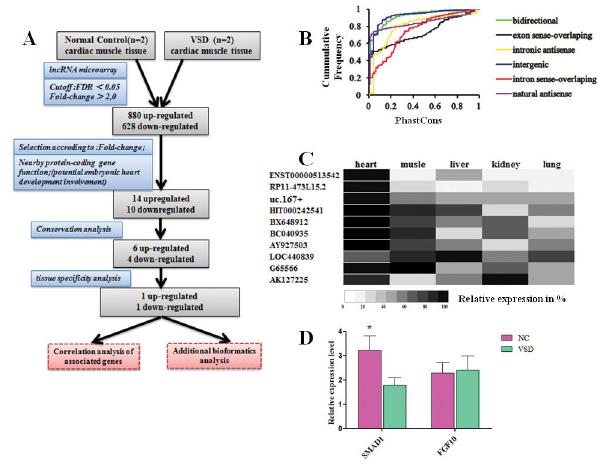
Figure 4. Validation of lncRNA candidates in VSD-affected cardiac tissue. ( A ) The overview of the pipeline for validation of lncRNA candidates in VSD. ( B ) Analysis of the conservation of all classes of dysregulated lncRNAs compared to conservative coding genes revealed an absence of high levels of conservation across species among the majority of lncRNAs. ( C ) The expression of the 10 selected heart expressed lncRNAs transcripts was validated by quantitative PCR in five human fetal tissues. The majority of the tested lncRNAs transcripts are predominately expressed in heart (percentage range; white, 0% to black, 100%). ( D ) To estimate the correlation of these two lncRNAs and the associated genes, we detected SMAD 1 and FGF10 expression in fetal heart tissues. We found that the expression of SMAD1 is significantly lower in VSD heart tissues than NC heart. No significant difference in FGF10 expression was observed between the two